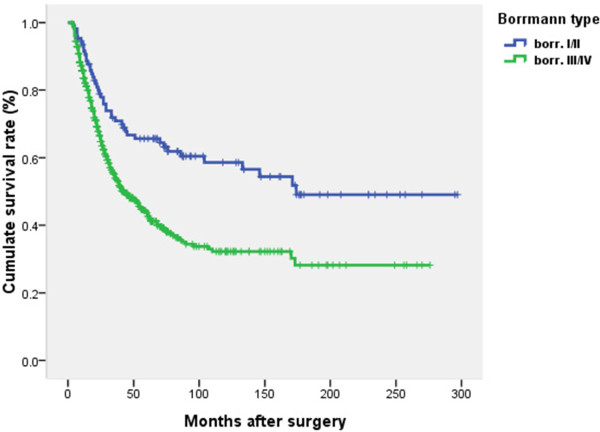
Survival curves in relation to Borrmann type by Kaplan Meier estimation. Poorer survival was seen in patients with Borrmann type III/IV compared to those with Borrmann type I/II. The difference was significant (χ2 = 16.59, P < 0.01) using log rank test.